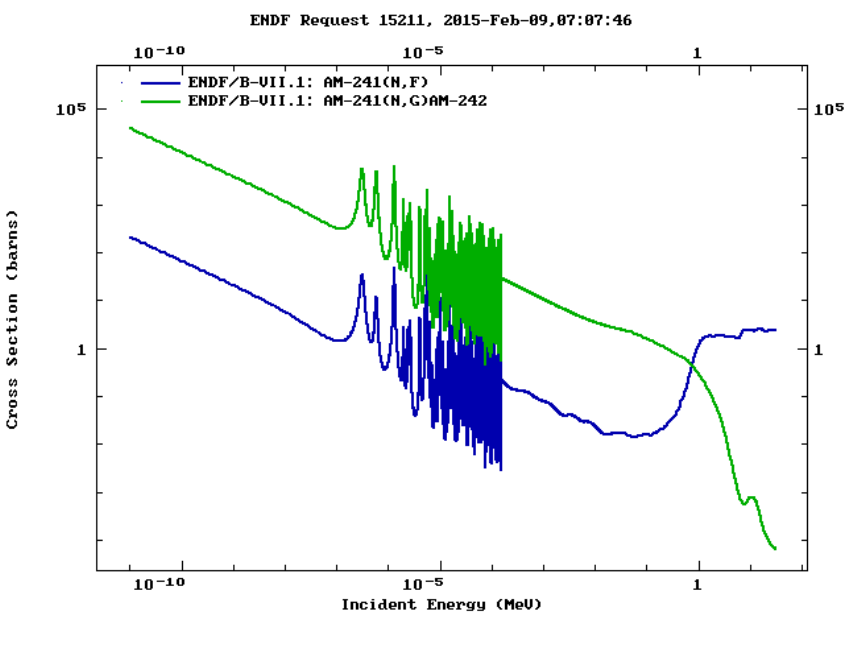
Figure 1. Am-241 neutron-caused fission (dark blue) and capture (green) cross section dependence on Energy